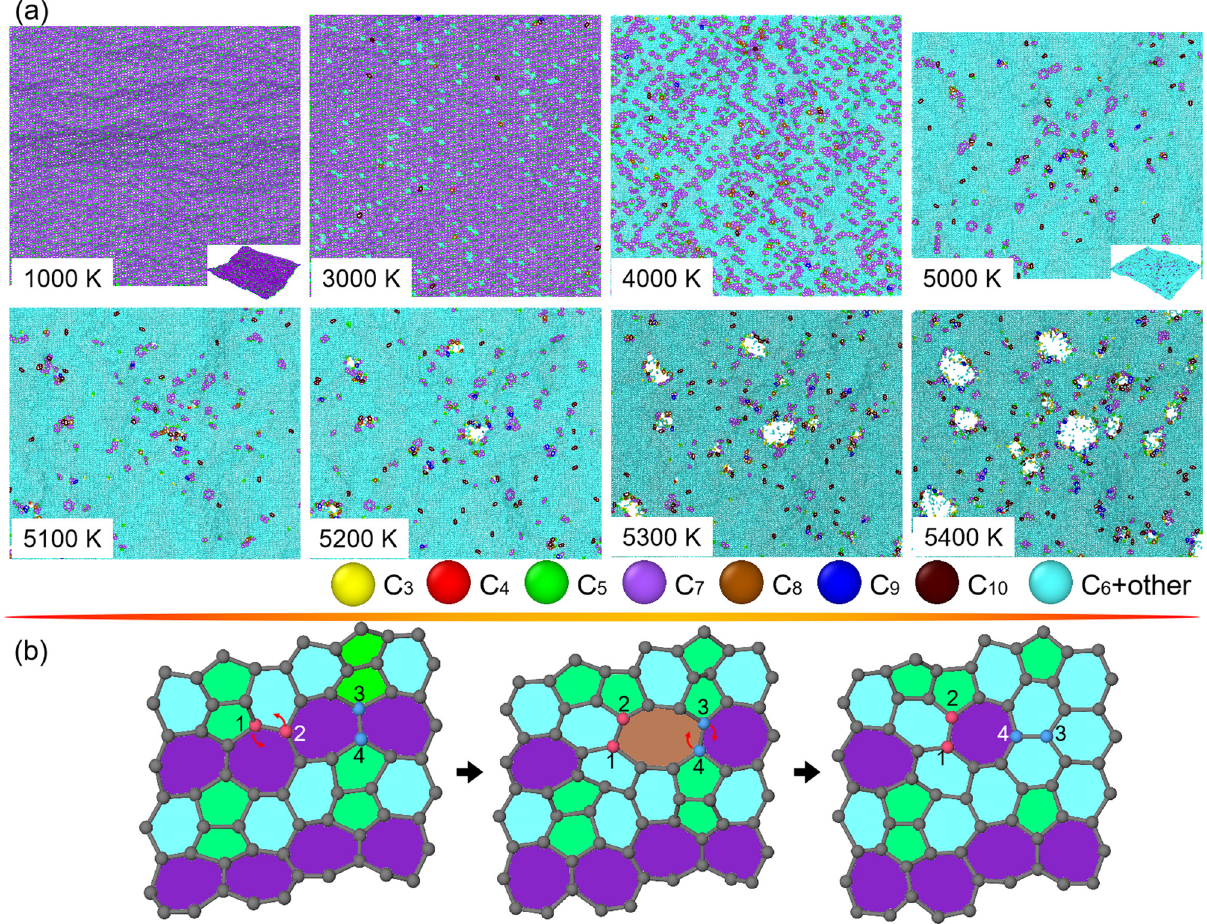
Figure 8: Structural changes in O - haeckelite upon heating. ( a ) Top views of O - haeckelite as the heating T increases from around 1,000 to 5,400 K. into melting phase. For eye - catching the thermally induced structural transformation in the O - haeckelite, carbon atoms in poly - gonal rings from trigon to decagon are di ff erently rendered. ( b ) Atomic illustration of nucleation of hexagons from pentagons, hexagons, and heptagons in a local region of O - haeckelite. Particularly, some carbon atoms are number - ranked, and arrows are marked for revealing the origins of microstructural